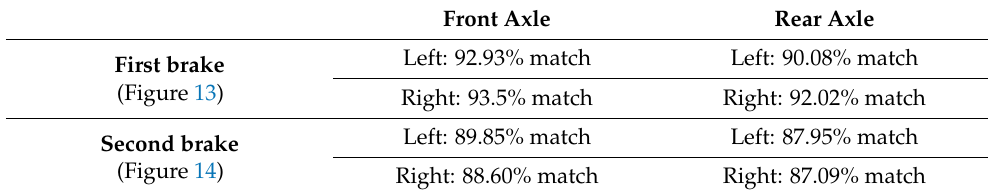
Table 2. Correlation coefficient for data comparison of brake forces for Figures 13 and 14.